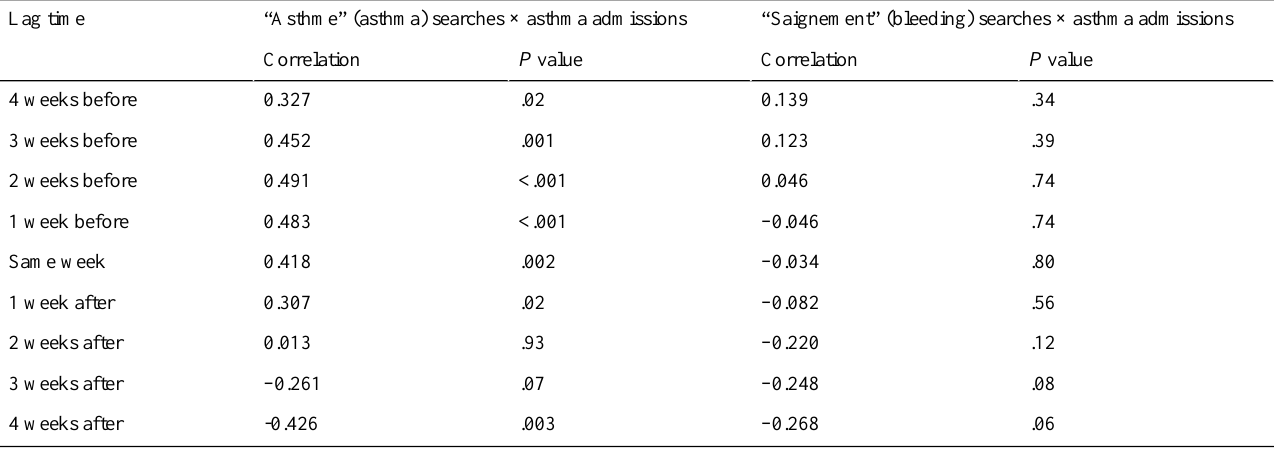
Table 2. Pearson correlations between Google search term and hospital admissions for